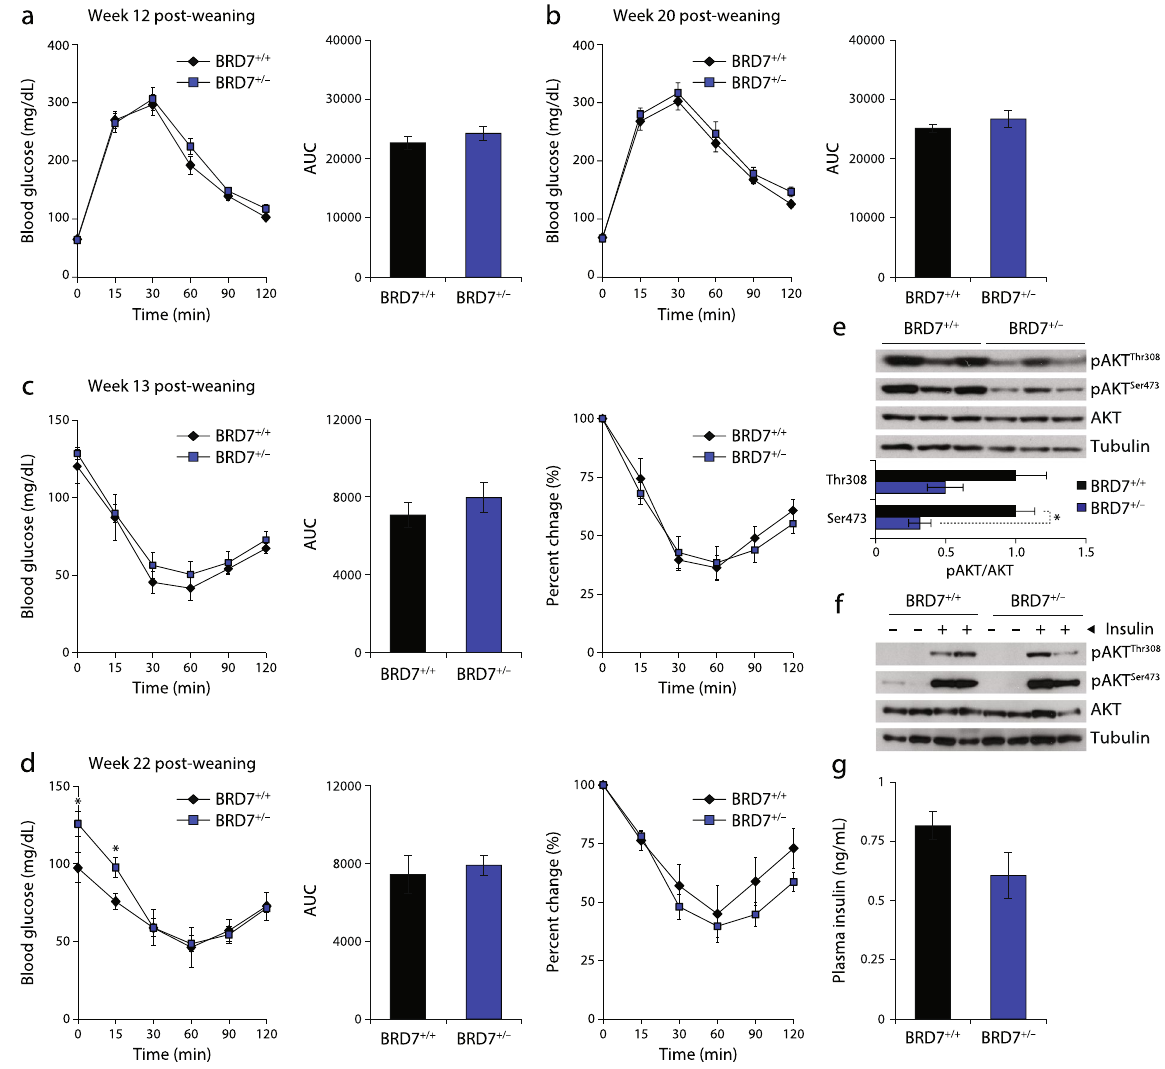
Figure 2. Reduced BRD7 levels have no effect on glucose homeostasis. ( a ) Glucose tolerance test (GTT) at week 12 post-weaning (left) (n = 9/group). Area under curve (AUC) of GTT (right). ( b ) GTT at week 20 post- weaning (left). Area under curve of GTT (right). ( c ) Insulin tolerance test (ITT) at week 13 (left). Area under curve of ITT (middle). Percent change of initial blood levels (right). ( d ) ITT at week 22 (left). Area under curve of ITT (middle). Percent change of initial blood glucose levels (right). ( e ) Immunoblots of pAKT Thr308 and pAKT Ser473 in the liver of BRD7 + / + and BRD7 + / − mice at 6 hours of fasting (top). Quantification of the blots showing the normalized ratio between pAKT and AKT (bottom). ( f ) Immunoblots of pAKT Thr308 and pAKT Ser473 in the liver of control and BRD7 + / − mice after infusion of saline or insulin (0.75 IU/kg) at 22 weeks (top). Quantification of the blots showing the normalized ratio between pAKT and AKT in insulin-infused livers (bottom). ( g ) Plasma insulin concentrations of 8-week old BRD7 + / + and BRD7 + / − mice at the 6-hour fasted state. Error bars are represented as mean ± SEM., P values were determined by Student’s t -test. ( * p < 0.05, ** p < 0.01, *** p < 0.001). Significance was determined by two-way analysis of variance (ANOVA) with Bonferroni multiple-comparison